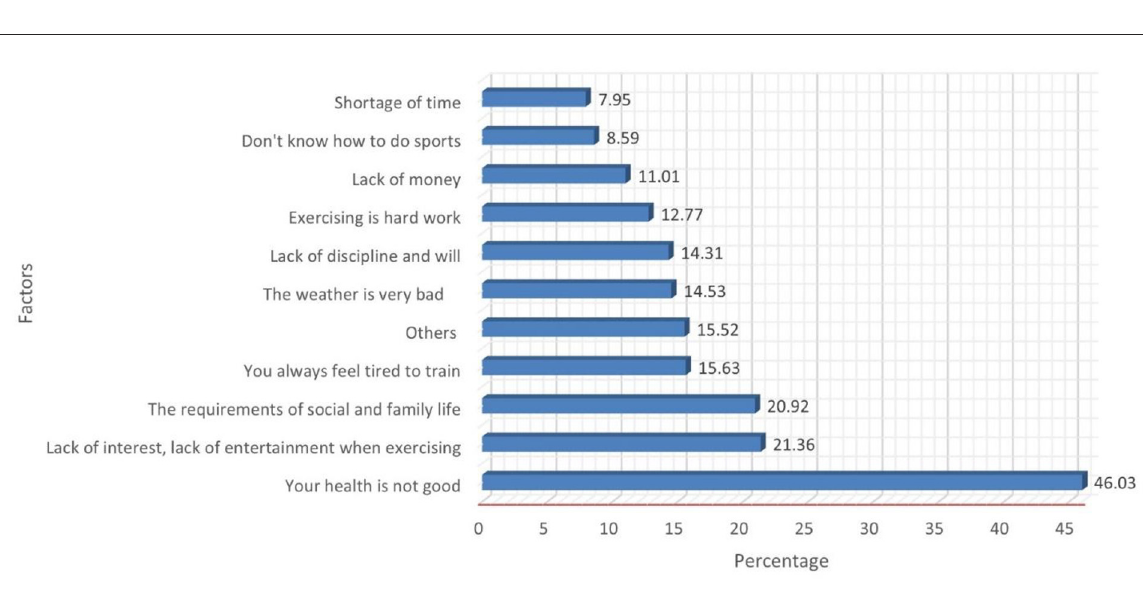
FIGURE2 Factors preventing from